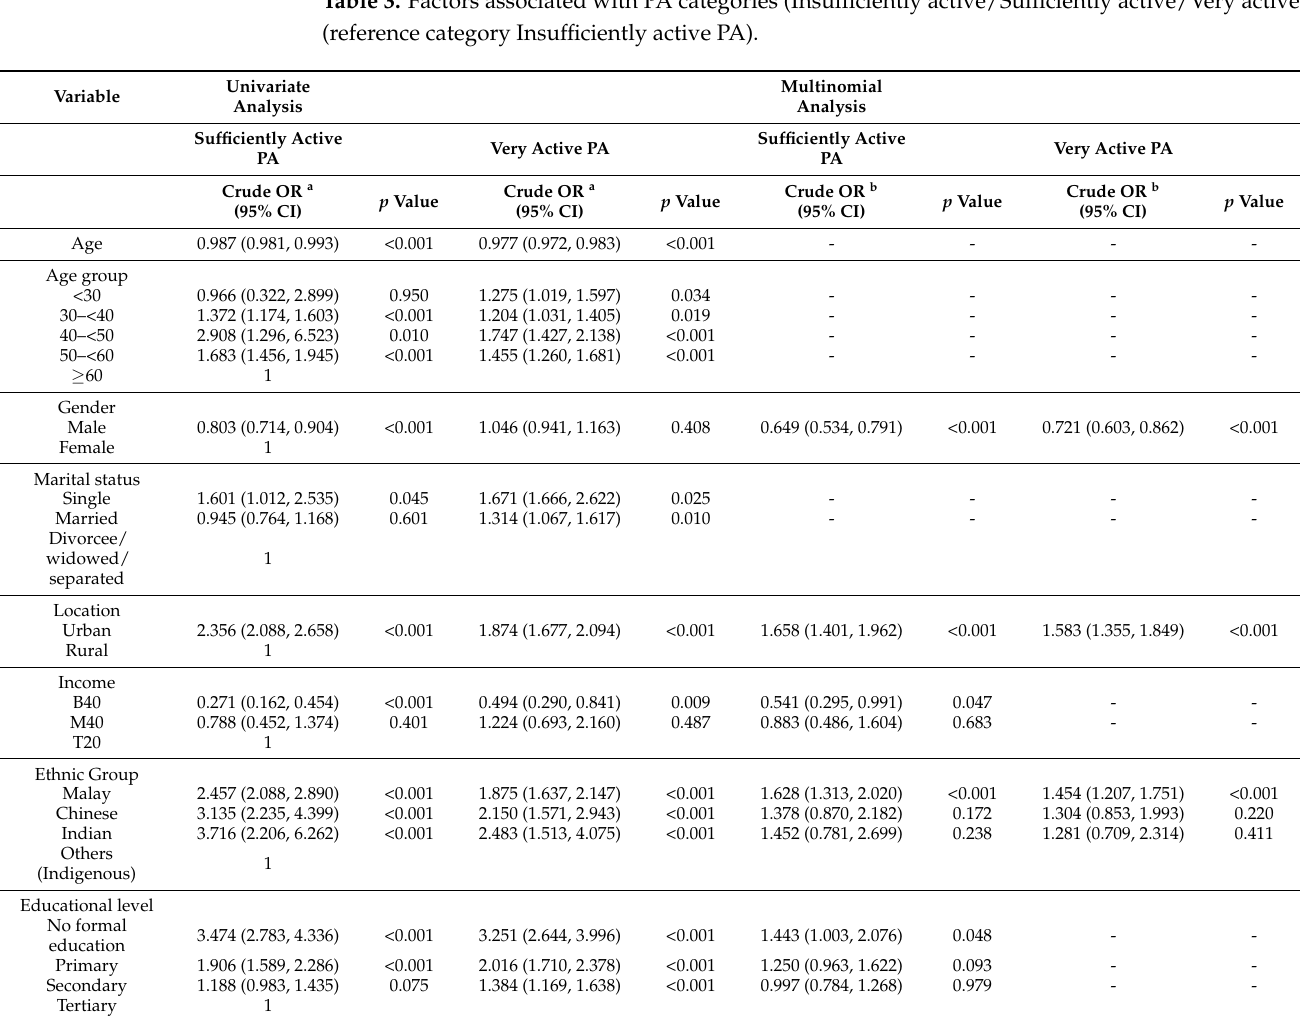
Table 3. Factors associated with PA categories (Insufficiently active/Sufficiently active/Very active) (reference category Insufficiently active